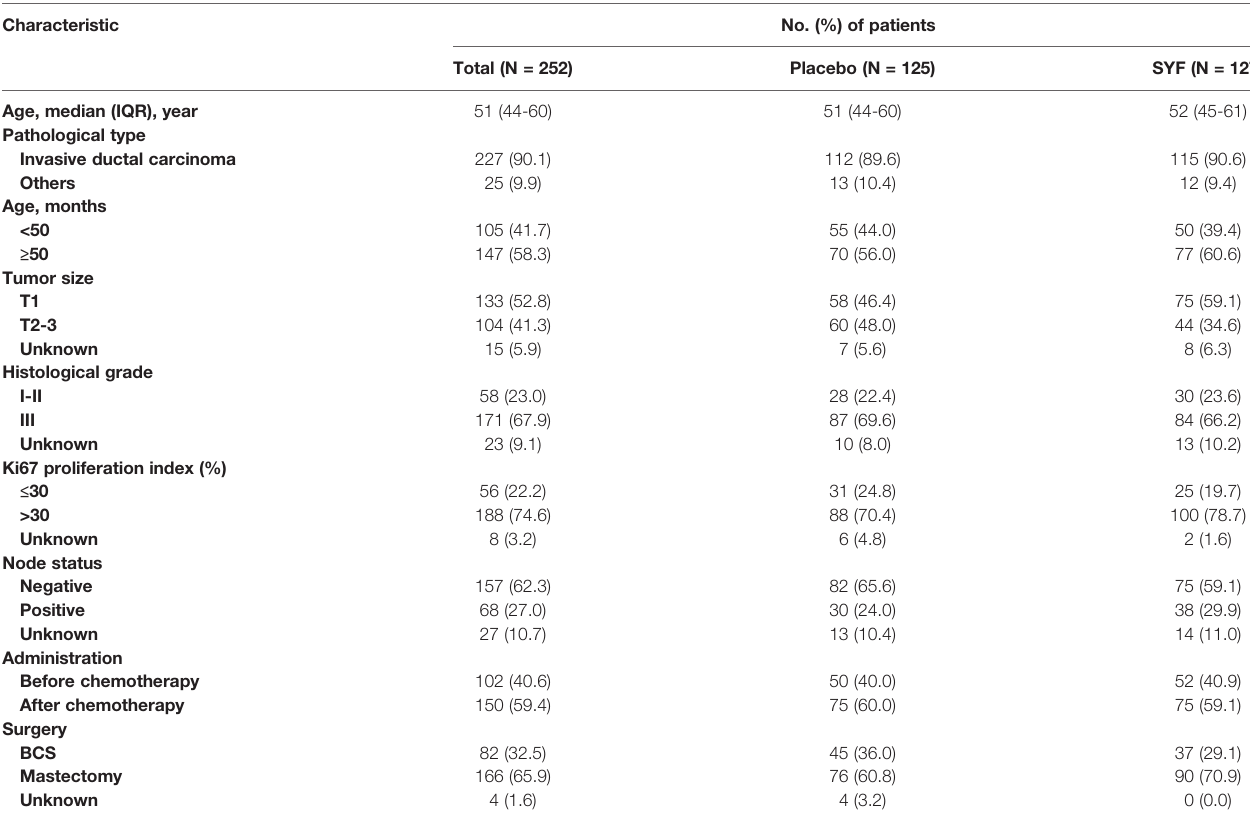
TABLE 1 | Patient baseline